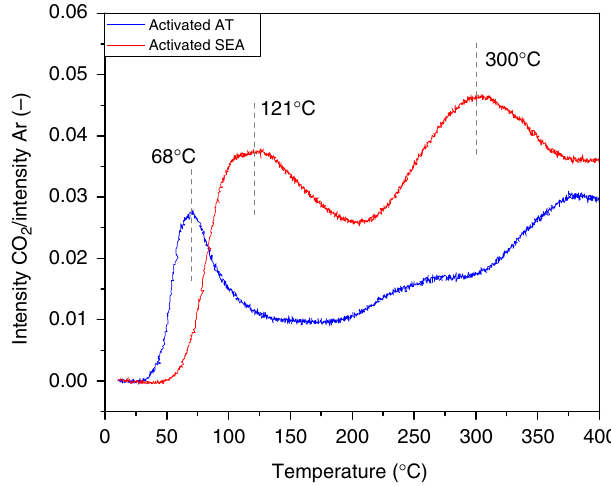
Fig. 4 CO-TPR of the 1wt.%Pt/CeO 2 catalysts. The reducibility of the catalysts synthesized by AT and SEA methods was monitored by observing the formation of CO 2 . Both catalysts were synthesized using TAPN as precursor and were activated prior to the experiment NATURE COMMUNICATIONS| (2019) 10:1358